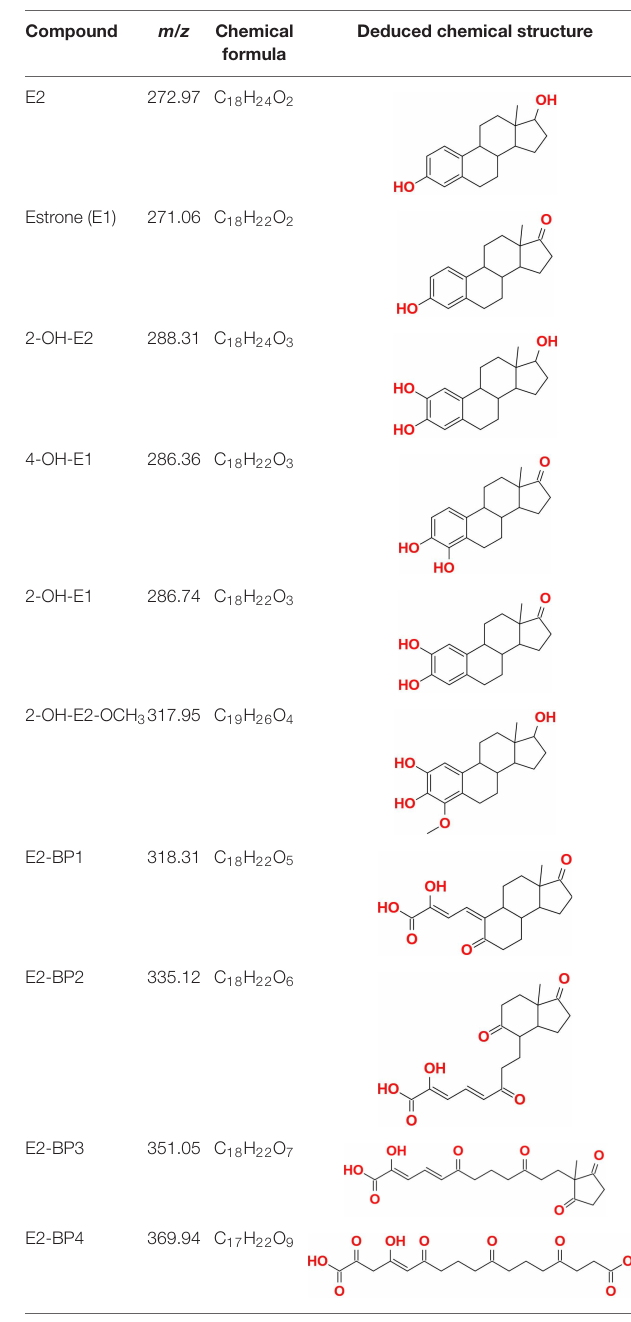
TABLE 4 | Partial metabolic by-products of 17 β -estradiol (E2) identified through GC-MS in the reaction process mediated by laccase ThLacc-S from Trametes hirsuta